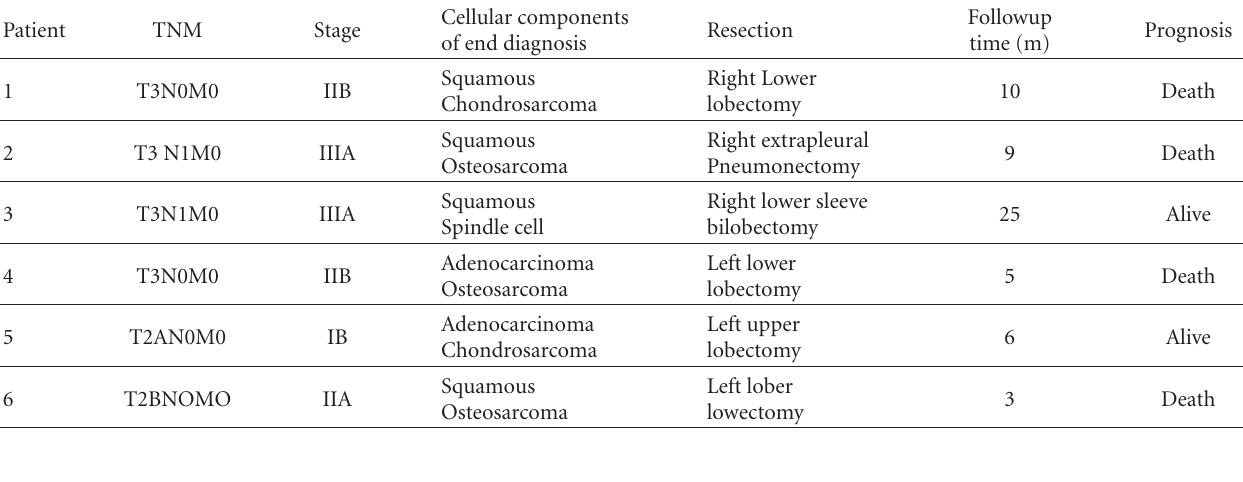
Table 2: Diagnostic characteristics of the lesions.